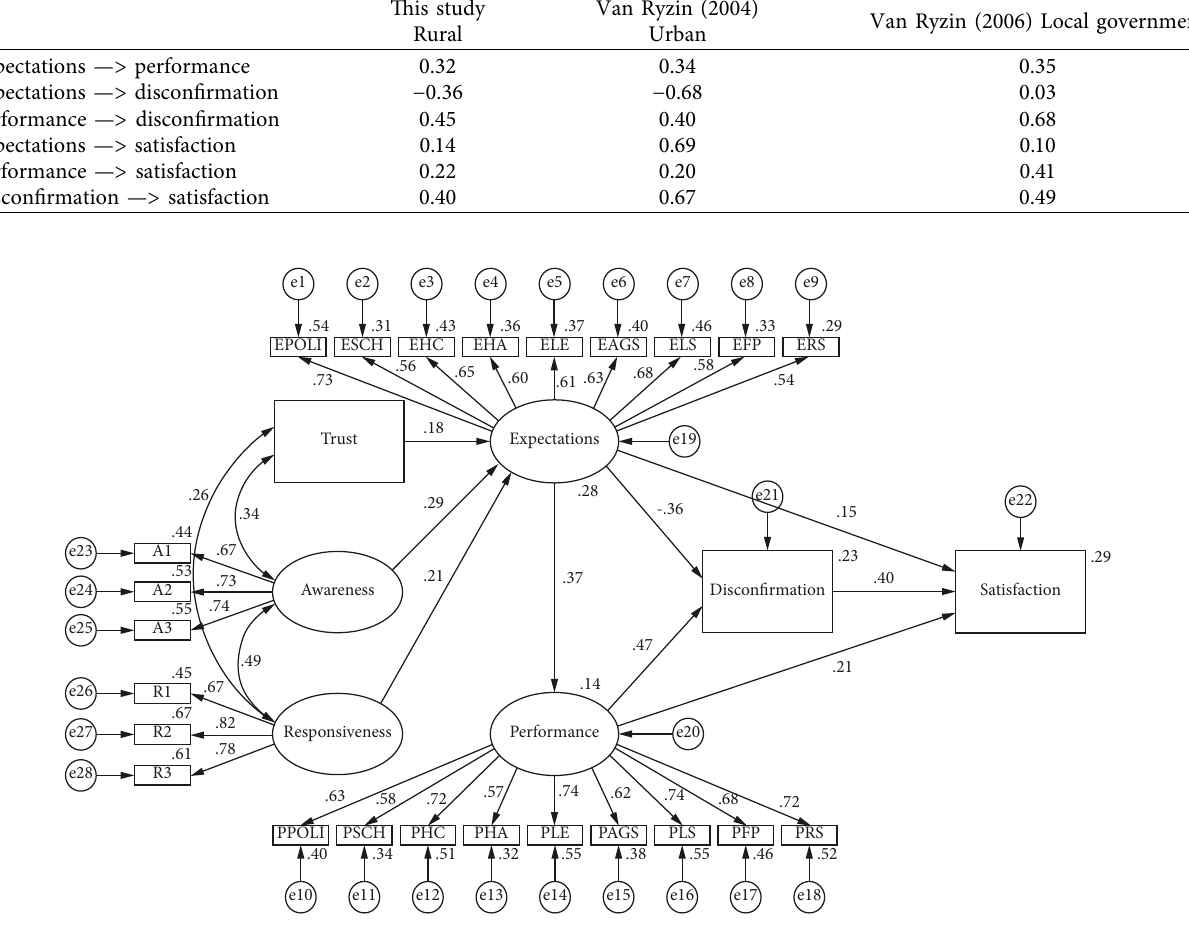
Figure 4: Model 2: the expanded expectancy disconfirmation model.